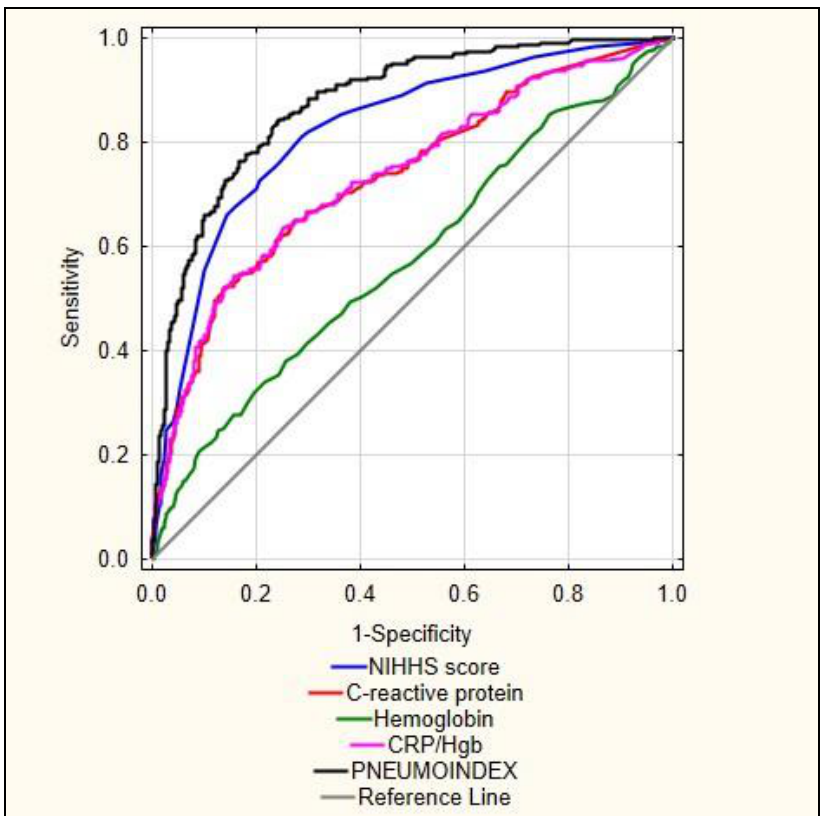
Figure 1. ROC analysis curves for pneumonia. Legend: NIHSS — National Institutes of Health Stroke Scale, CRP/HGB — C-reactive protein-to-hemoglobin ratio. Table 6. Details of the receiver operating characteristics (ROC) analysis for pneumonia.